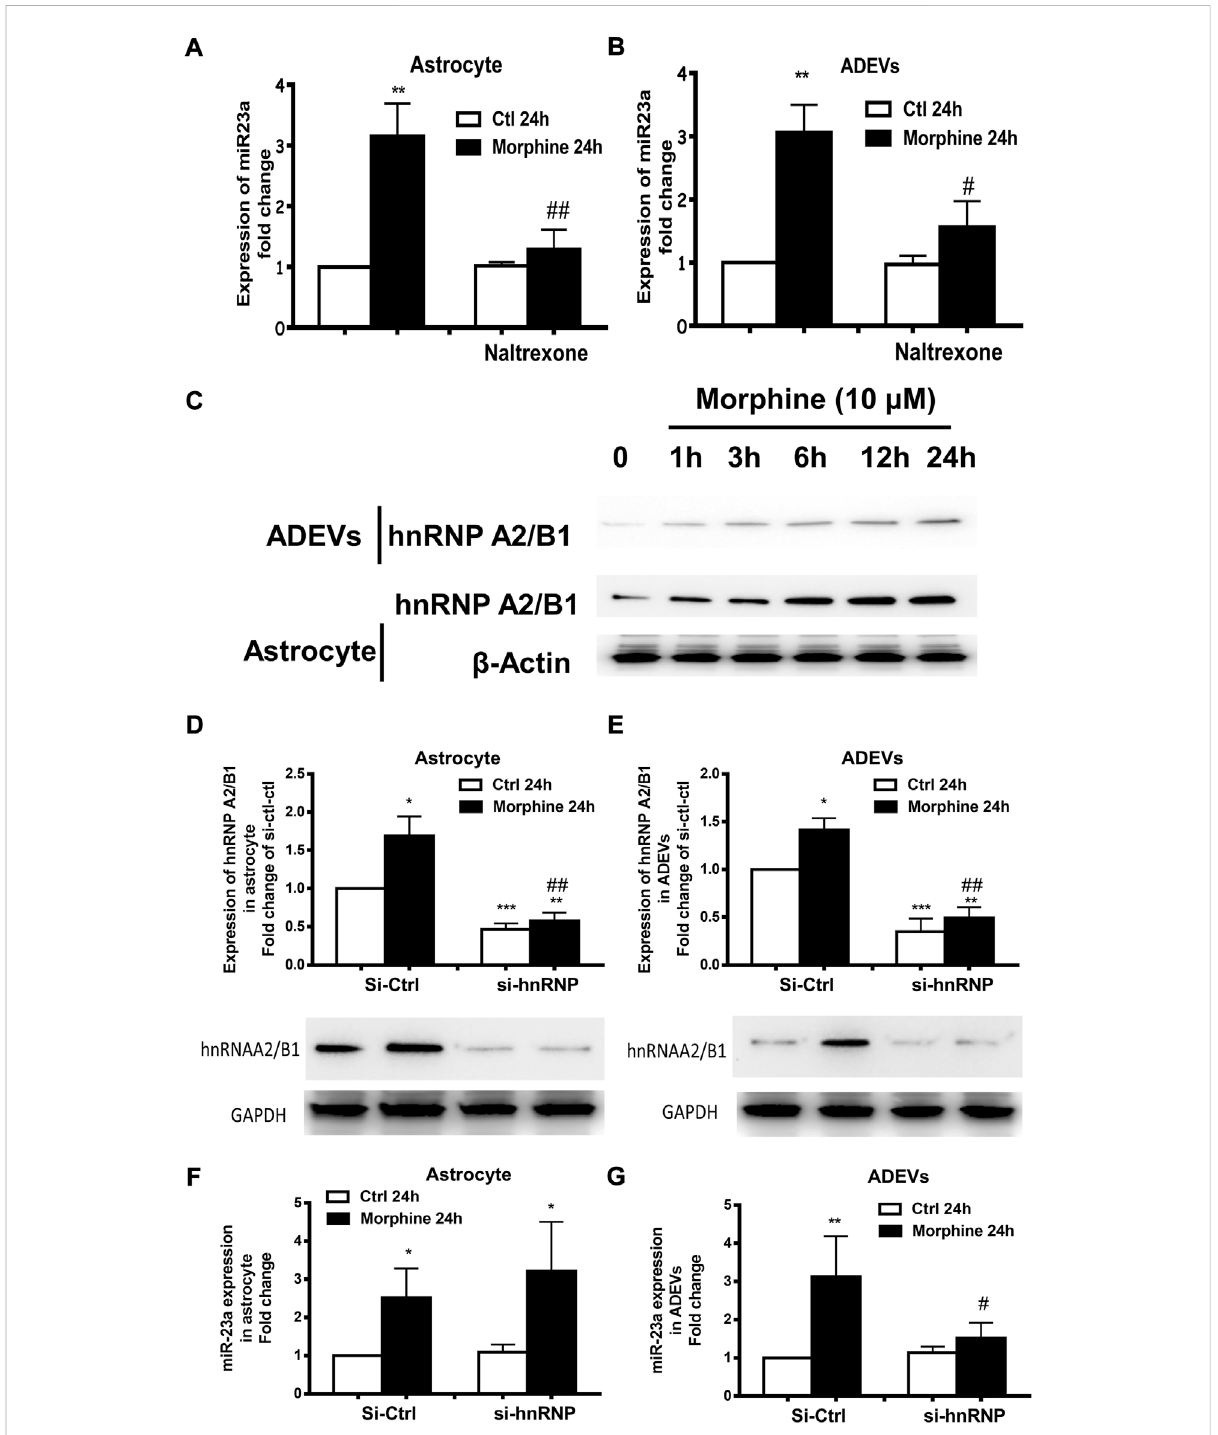
FIGURE 5 Morphine-mediatedupregulationofmiR-23ainADEVsinvolvesmureceptorandhnRNPA2/B1. (A,B) Astrocyteswerepretreatedwithnaltrexone(10 μ M)for 1 h,followedby24 hexposuretomorphine.TheexpressionofmiR-23ainastrocytes (A) andADEVs (B) wasassessedusing real-timePCR.Eachsetofresultswas quanti fi eduponthreeindependentexperiments. (C) RepresentativewesternblotimagesofhnRNPA2/B1expressioninthelysatesofcellsandADEVsfromastrocytes exposedtomorphineforvarioustimepoints(1 – 24 h). (D,E) RepresentativewesternblotimagesofhnRNPA2/B1expressioninthelysatesofcells (D) orADEVs (E) from astrocytes transfected with control siRNA or si-hnRNP A2/B1 followed by morphine exposure. Each set of results was quanti fi ed upon three independent experiments. (F,G) AstrocytesweretransfectedwitheithercontrolsiRNAorsi-hnRNPA2/Bfor24 h,followedbymorphineexposurefor24 h.TheexpressionofmiR- 23ainastrocytes (F) andADEVs (G) wasassessedusingreal-timePCR.Eachsetofresultswasquanti fi eduponthreeindependentexperiments.Alldataarepresented as mean ± SD, * p < 0.05, ** p < 0.01, *** p < 0.001 vs. si-ctl-control group; # p < 0.05, ## p < 0.01 vs. si-ctl-morphine group using one-way ANOVA